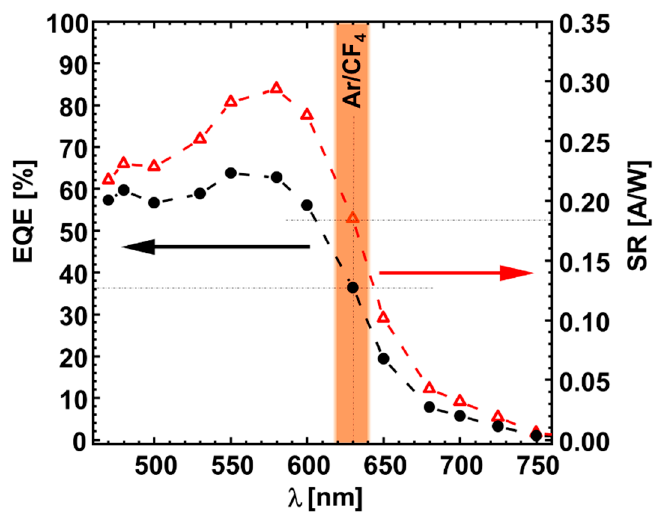
Figure 3. External Quantum Efficiency ( EQE) (black curve and left axis) and Spectral Response (SR) (red curve and right axis) of the OPD layer deposited on the readout matrix. The broad emission band of Ar/CF 4 with a peak at around 630 nm is represented by the orange region.